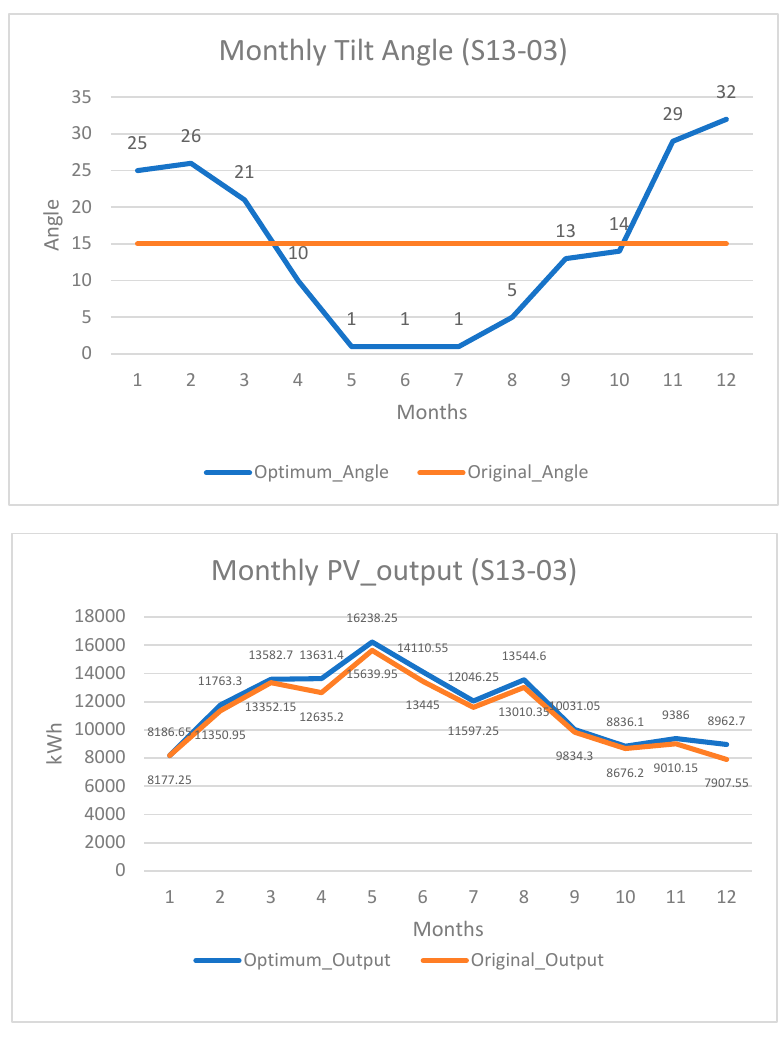
Figure A3. Monthly tilt angles and outputs of S13-03 module.